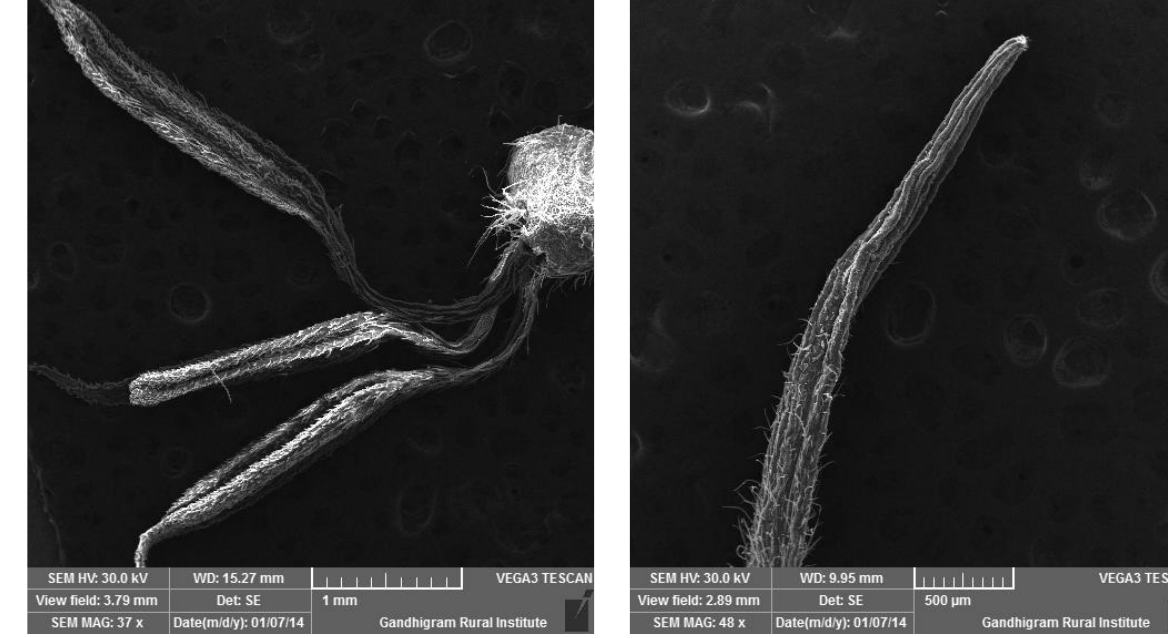
Image 1g. SEM of